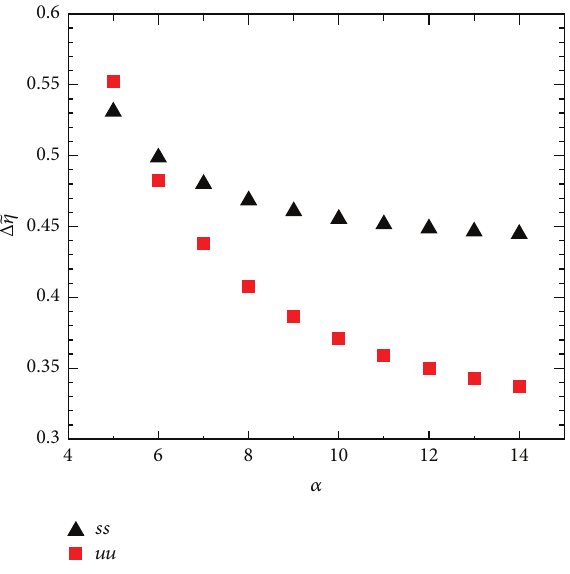
Figure 7: The width 𝜎 varies as a function of 𝜏 󸀠 , the time at which charges are created, and three curves correspond to three different local scattering rate 𝛼 (color online).